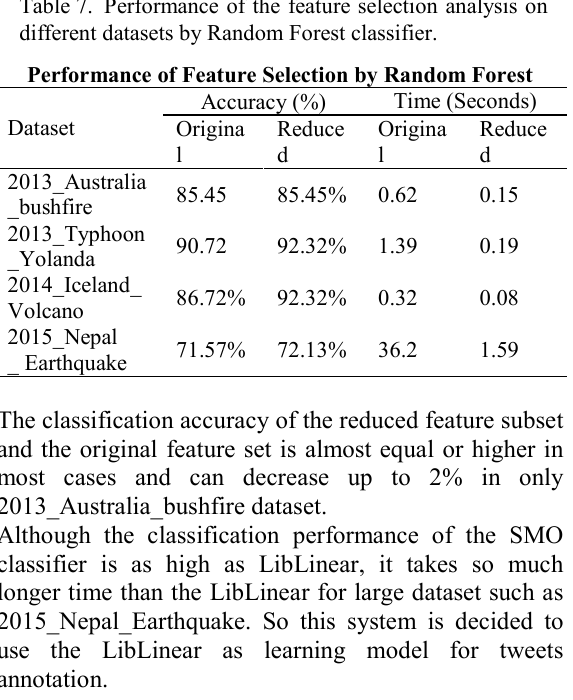
Table 8. Performance of the feature selection analysis on different datasets by LibLinear classifier.